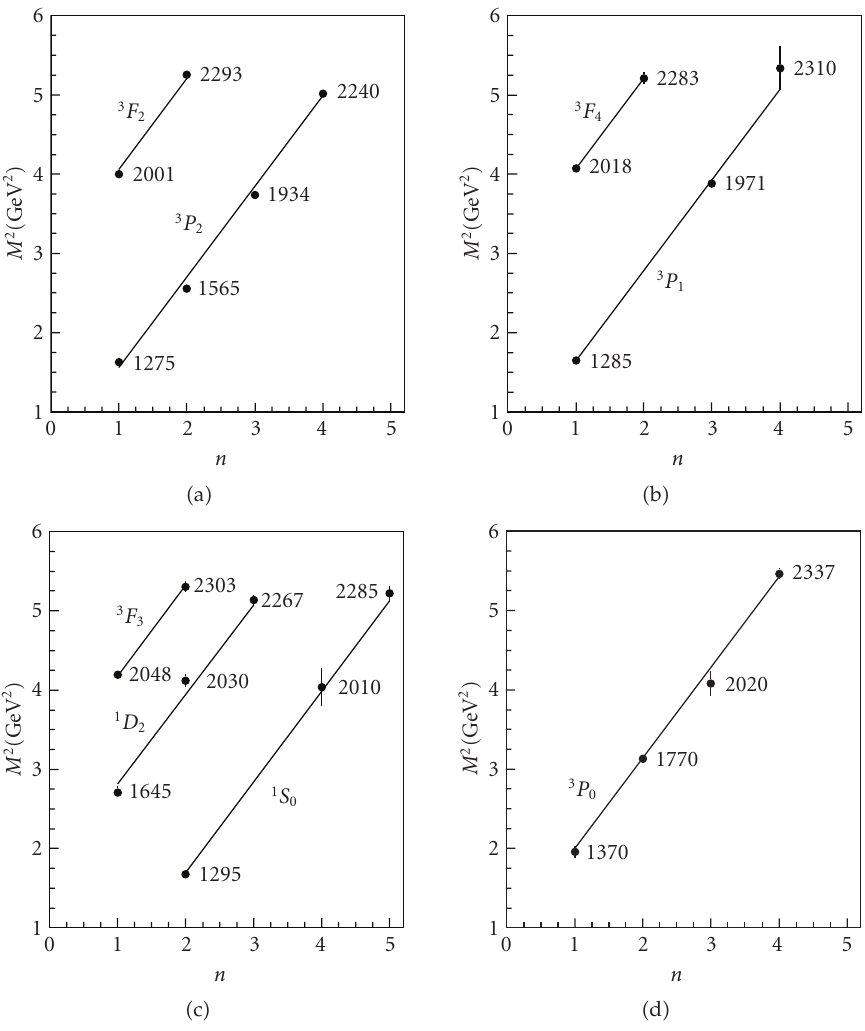
Figure 1: Trajectories of I (cid:12) 0, C (cid:12) (cid:5) 1 light mesons; n is the principal (cid:2) radial (cid:3) quantum number and n (cid:12) 1 for ground-states; M is the mass and points (cid:2) with errors (cid:3) show known states while numbers indicate masses in